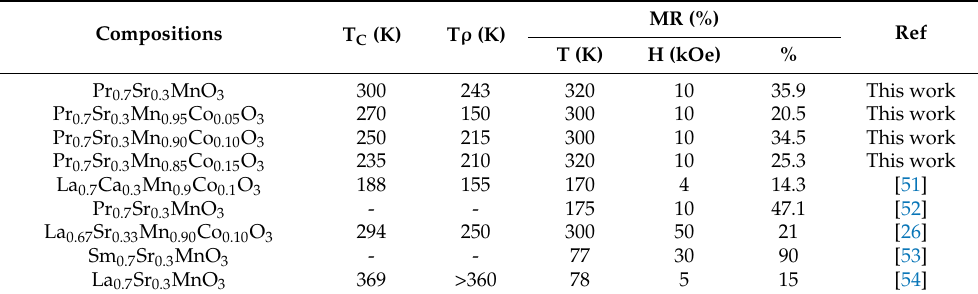
Table 7. MR values (%) at room temperature and in a magnetic field H = 10 kOe for Pr (cid:2868).(cid:2875) Sr (cid:2868).(cid:2871) Mn ((cid:2869)(cid:2879)(cid:2934)) Co (cid:2934) O (cid:2871) samples (x = 0, 0.05; 0.10 and 0.15) compared to several systems . Compositions